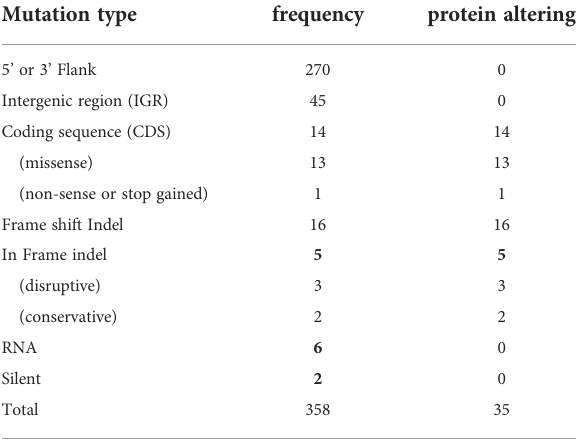
TABLE 3 Variants in the Lmj LCB2-/- genome identi fi ed using WGS. See S2 Table and S3 Table for a detailed list with all